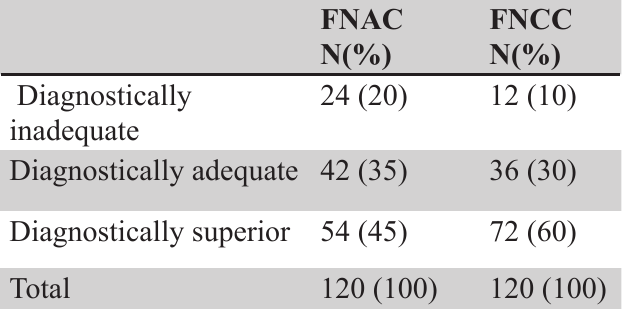
Table 3: Diagnostic performance of FNAC vs FNCC